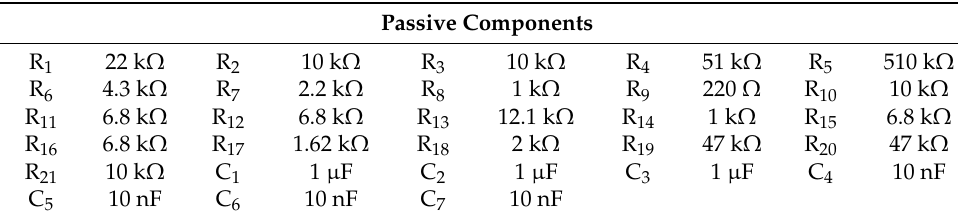
Figure 1. Proposed Arduino-ADC-based low-cost FMCW radar system for through-wall detection: ( a ) system block diagram and ( b ) radar prototype. Table 1. List of components used in the proposed FMCW radar